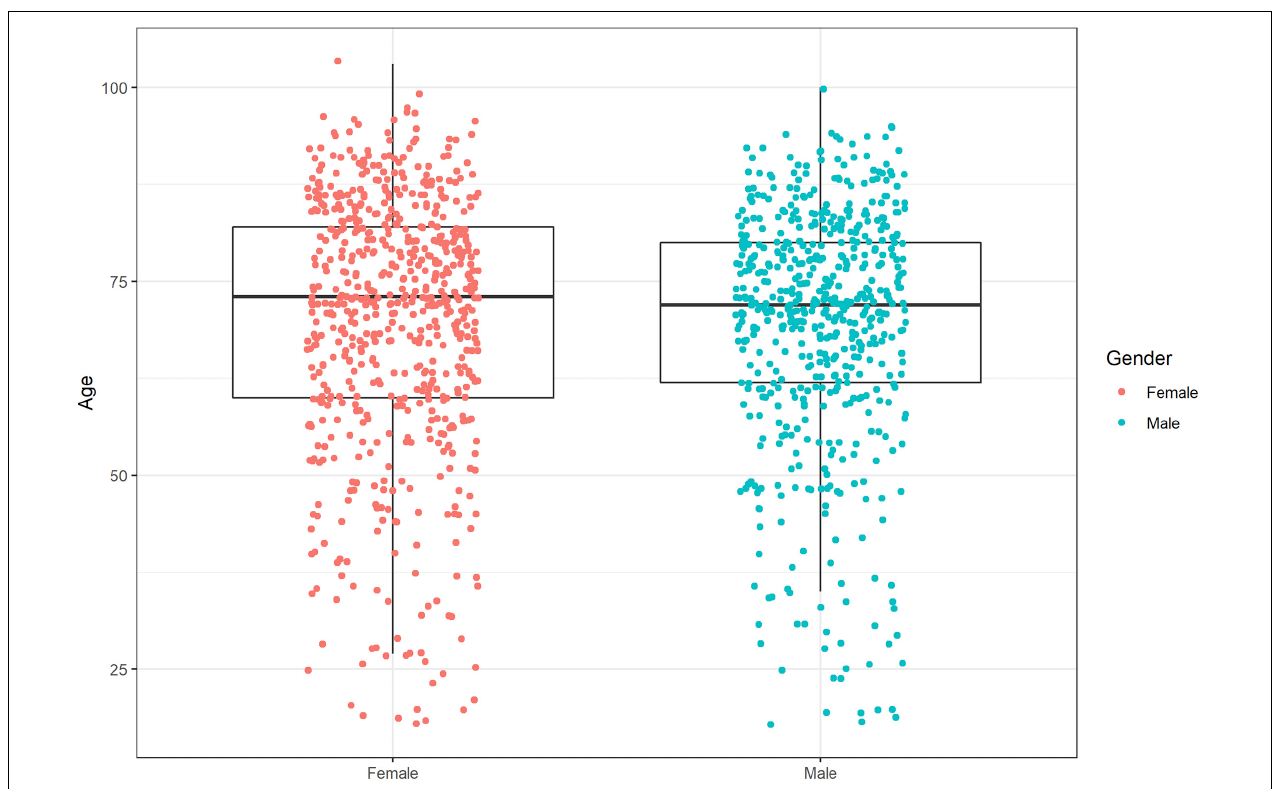
FIGURE 1 | Boxplot of age and gender of hospitalized adults with confirmed viral RTI, in three consecutive seasons